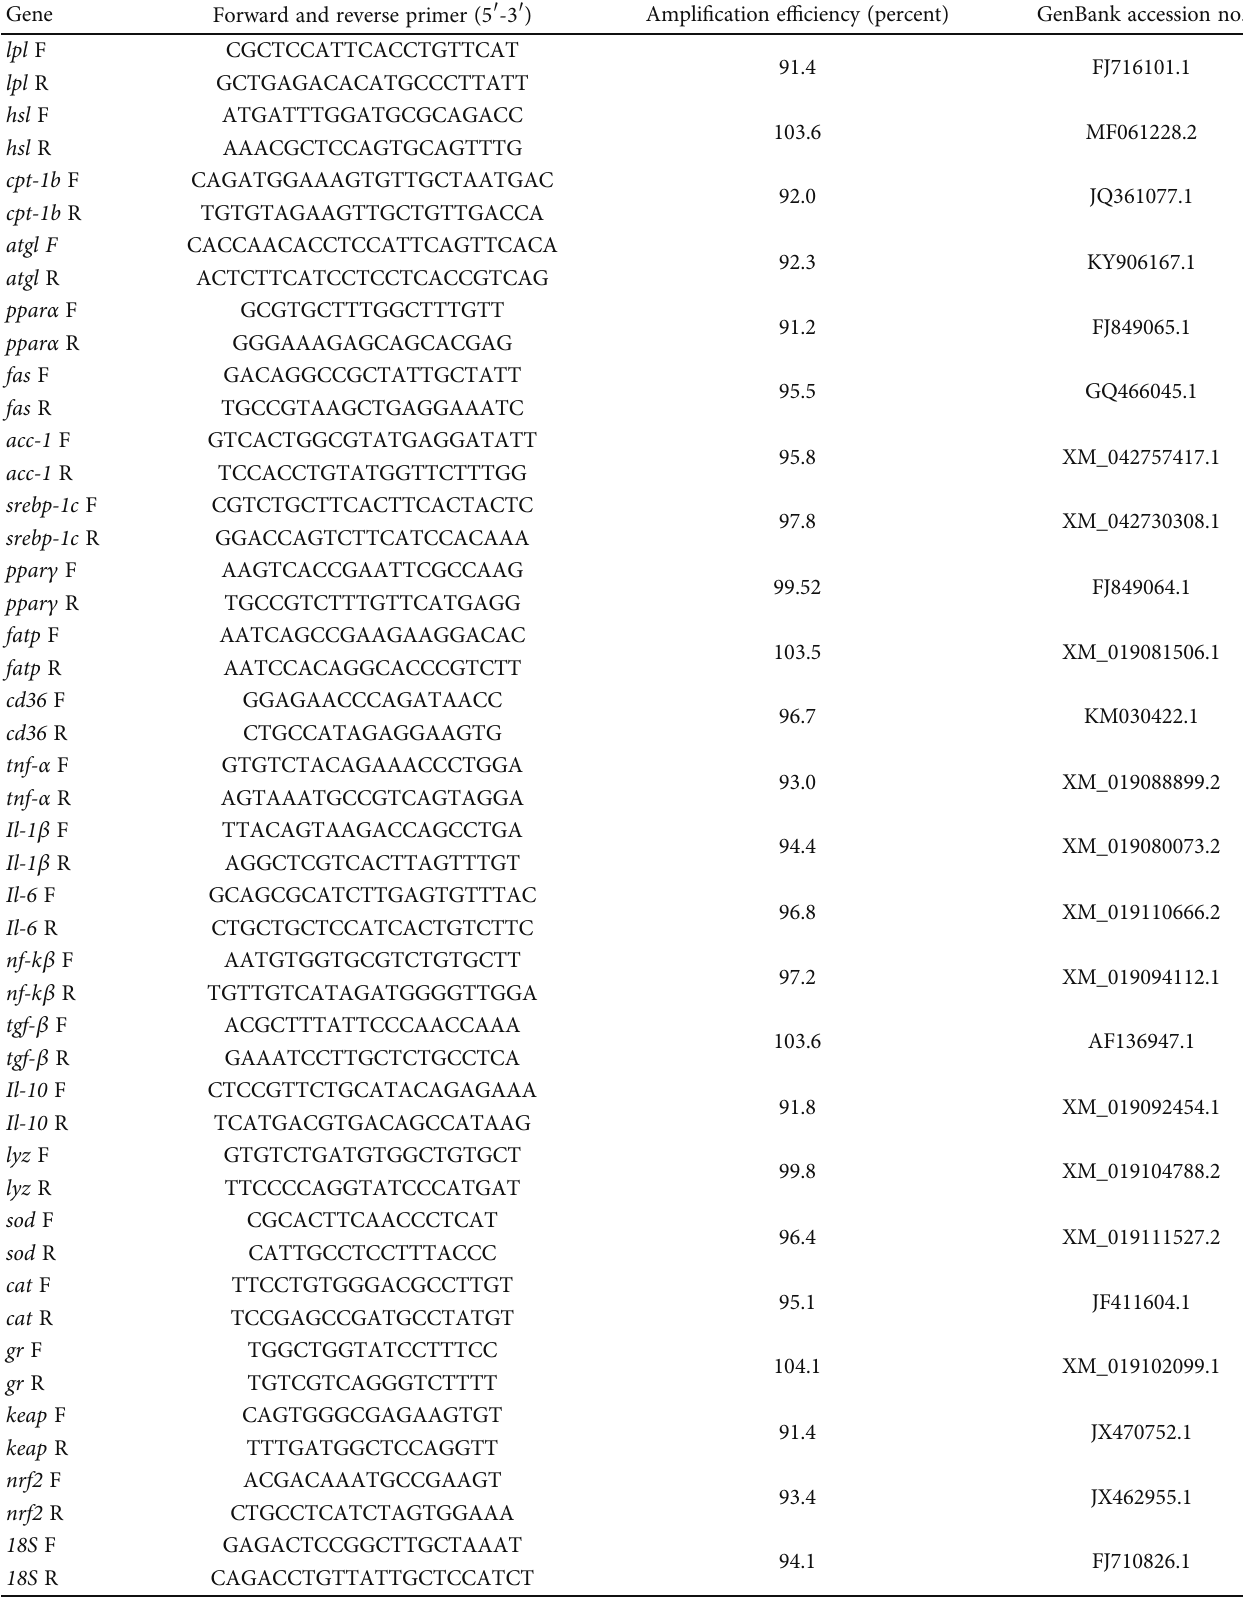
Table 2: The primers were used in quantitative real-time PCR in this experiment.